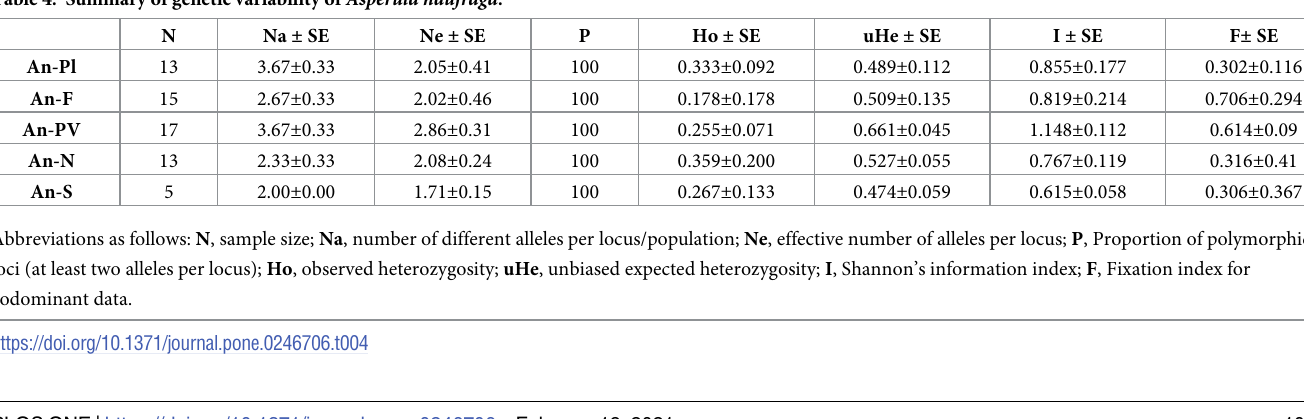
Twelve alleles in total were revealed from the three amplified SSR loci in 63 individuals of A . naufraga . Since the average number of amplified alleles per locus was four (S1 Table), all microsatellite markers were retained for further analysis. The allelic size ranged from 150 to 220 base pairs. More specifically, allele size for the GA_1 locus ranged between 150–175, for GA-50A between 165–200 and for GA_30C between 190–220 base pairs. PIC value for each SSR marker was 0.452 for the GA_50A locus, 0.629 for GA_30C and 0.667 for GA_1. The number of alleles per locus and subpopulation ( N ) ranged from 2.00 for An-S to 3.67 a for An-Pl and An-PV, respectively. The number of effective alleles ( N ) per locus ranged from e 1.71 (An-S) to 2.86 (An-PV). The Chi-Square Tests performed to test for Hardy-Weinberg Equilibrium, revealed that except for loci GA-50 and GA-1 in An-S and GA_30 in An-Pl, in all other cases the subpopulations deviated significantly from Hardy-Weinberg equilibrium. Null alleles were detected in all subpopulations by both Micro-checker, and FreeNA. The average frequency of null alleles for each SSR marker in all subpopulations studied was 0.06 for GA_1, 0.20 for GA_50A and 0.25 for GA_30C. The only cases where null alleles were not detected were in subpopulations An-N and An-S for the GA_1 marker. Regarding diversity parameters, the mean unbiased expected heterozygosity (or else gene diver- sity) of subpopulations was moderate (u H = 0.532); subpopulation An-S, which is the smallest sub- e population of the species, showed the lowest value (u H = 0.474) whereas the largest subpopulation e (An-PV) exhibited the highest (u H = 0.661).The mean observed heterozygosity within the subpop- e ulations of A . naufraga was relatively low ( H = 0.278). Subpopulation An-F exhibited the lowest o value ( H = 0.178), whereas subpopulation An-N the highest ( H = 0.359) (Table 4). o o Table 4. Summary of genetic variability of Asperula naufraga